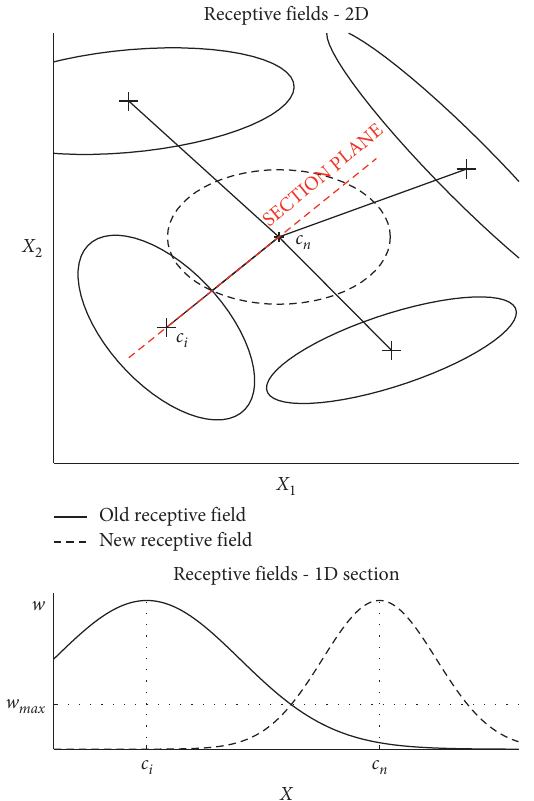
Figure 3: Demonstration of adding a new reference field to the set of RFWR local models and matching its dimensions to fit the surrounding reference